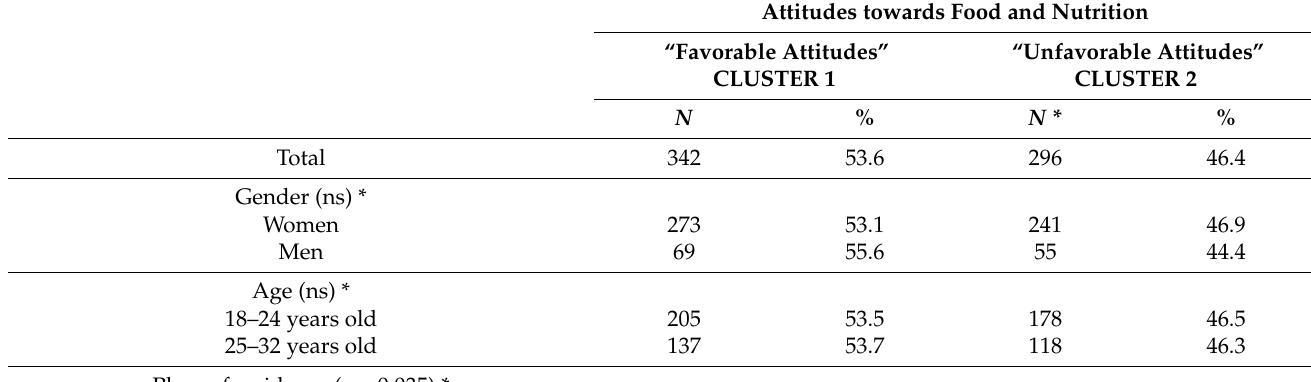
Table 6. Characteristics of the